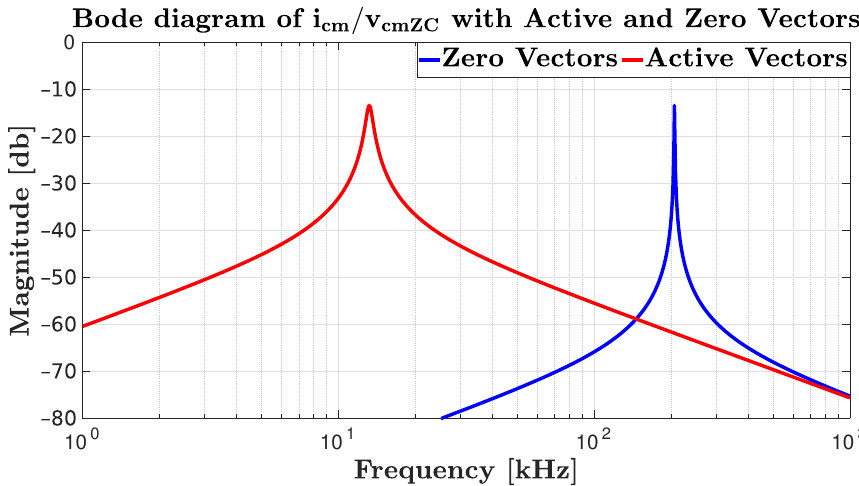
Figure 12. Bode diagram for Zero (blue) and Active (red)